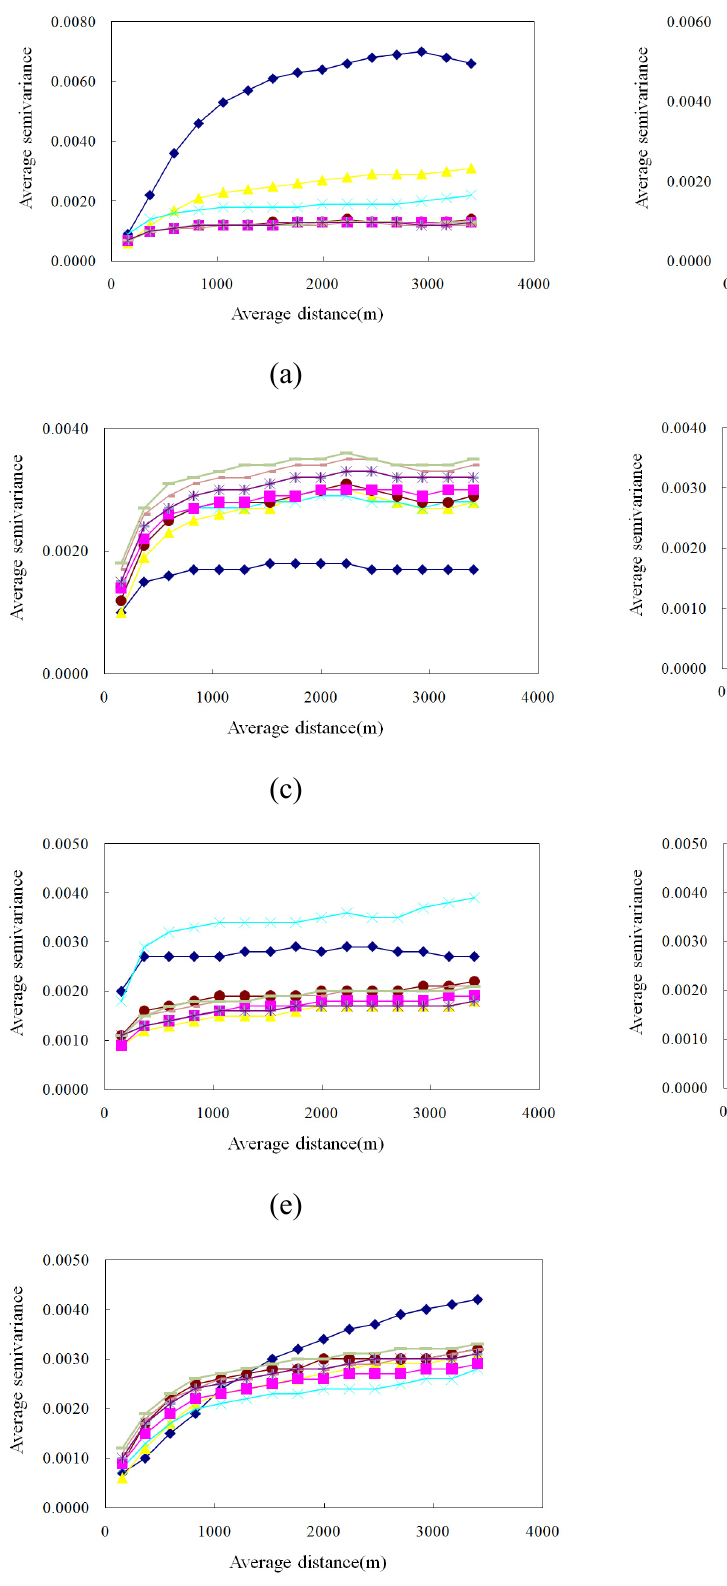
Figure 9. Experimental variograms of NDVI simulations using different samples on (a) 1996/11/08, (b) 1999/03/06, (c) 1999/10/31, (d) 2000/11/27, (e) 2001/11/20, (f) 2003/12/17, and (g)